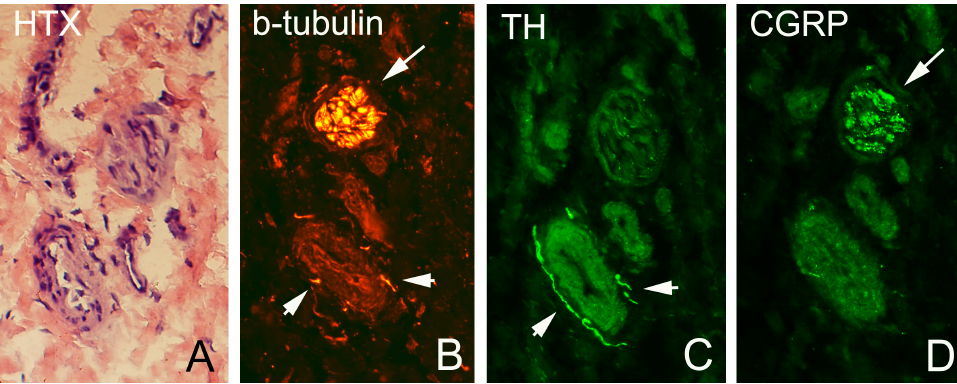
Figure 4. Parallel sections of superficial peritendinous tissue of the patellar tendon stained for HTX ( A ), bIII-tubulin ( B ), TH ( C ) and CGRP ( D ). TH immunoreactions are most pronounced in close vicinity to blood vessels and in perivascular spaces (arrow heads, ( C )), CGRP immunoreactions are most pronounced in nerve fascicles (arrows, ( D )).